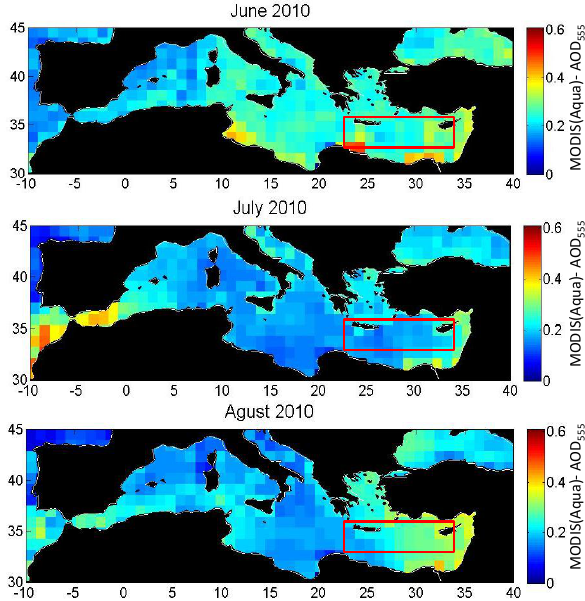
Figure 6. Monthly mean AOD during June–August 2010 over the Mediterranean basin. Red rectangular boxes present the